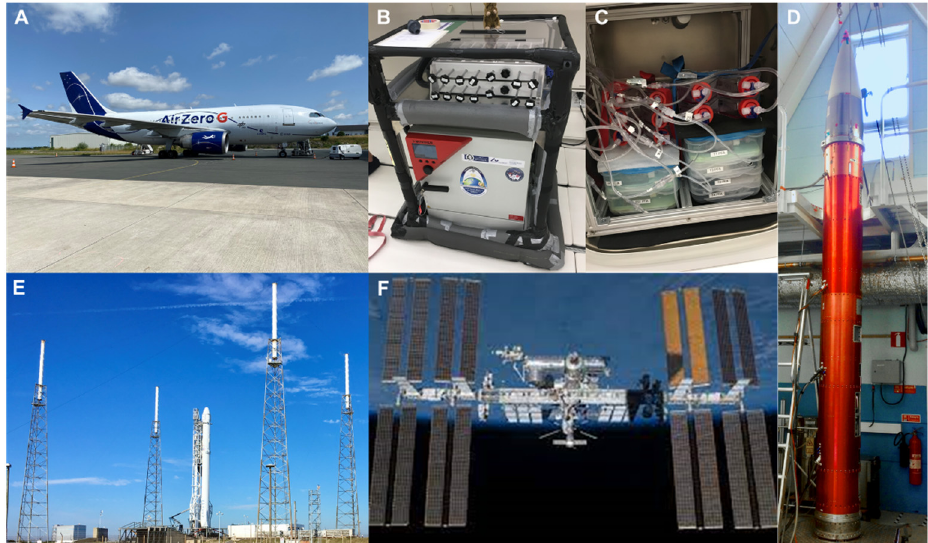
Figure 2. Real microgravity platforms. ( A ): 37th DLR Parabolic flight campaign, Airbus A310 Zero- g aircraft from the company Novespace in Paderborn, Lippstadt Airport, on 18 July 2021, ( B ): the PFC flight rack with an incubator and ( C ): open door of the incubator and boxes containing the cell culture flasks with DU-145 PCC. ( D ): Payload of a TEXUS-type sounding rocket (SSC, ESRANGE, Kiruna, Sweden; ( E ): SpaceX CRS-8 rocket on the launch pad, Kennedy Space Center (KFC), FL, USA; ( F ): the International Space Station.